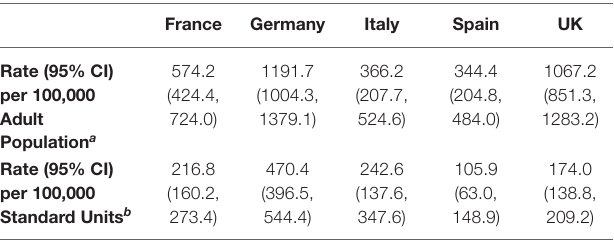
TABLE 1 | Last 90 day non-medical use of GABA analogs by country.